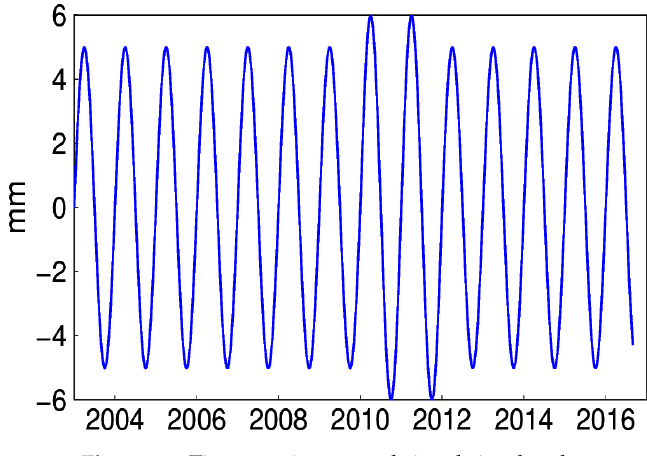
Figure 11. Time-varying annual signal simulated.